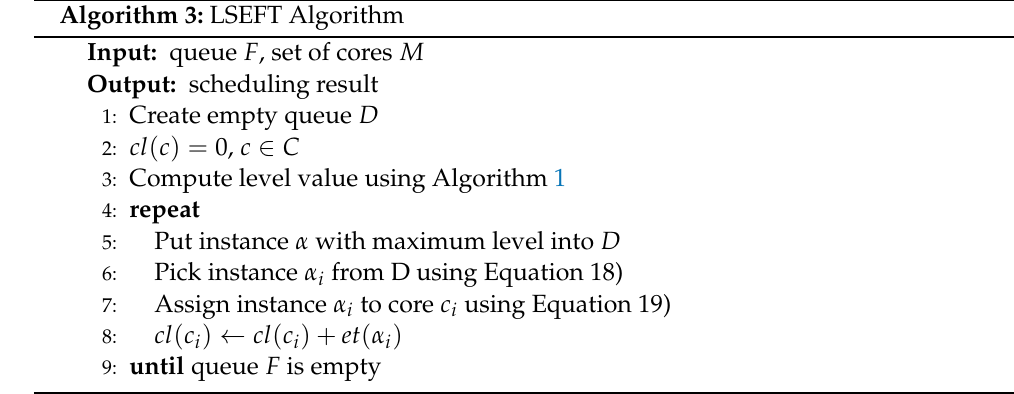
Algorithm 3: LSEFT